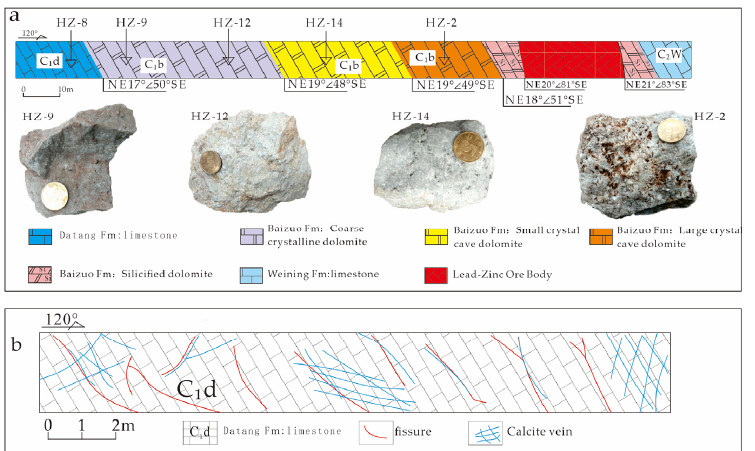
Figure 5. Geological information recording and sampling location of No. 2 stope tunnel in the 1211 middle section of the Qilinchang ore section of the Huize lead–zinc mine: ( a ) sampling location; ( b ) calcite veins and fractures in the Lower Carboniferous Datang Formation limestone.